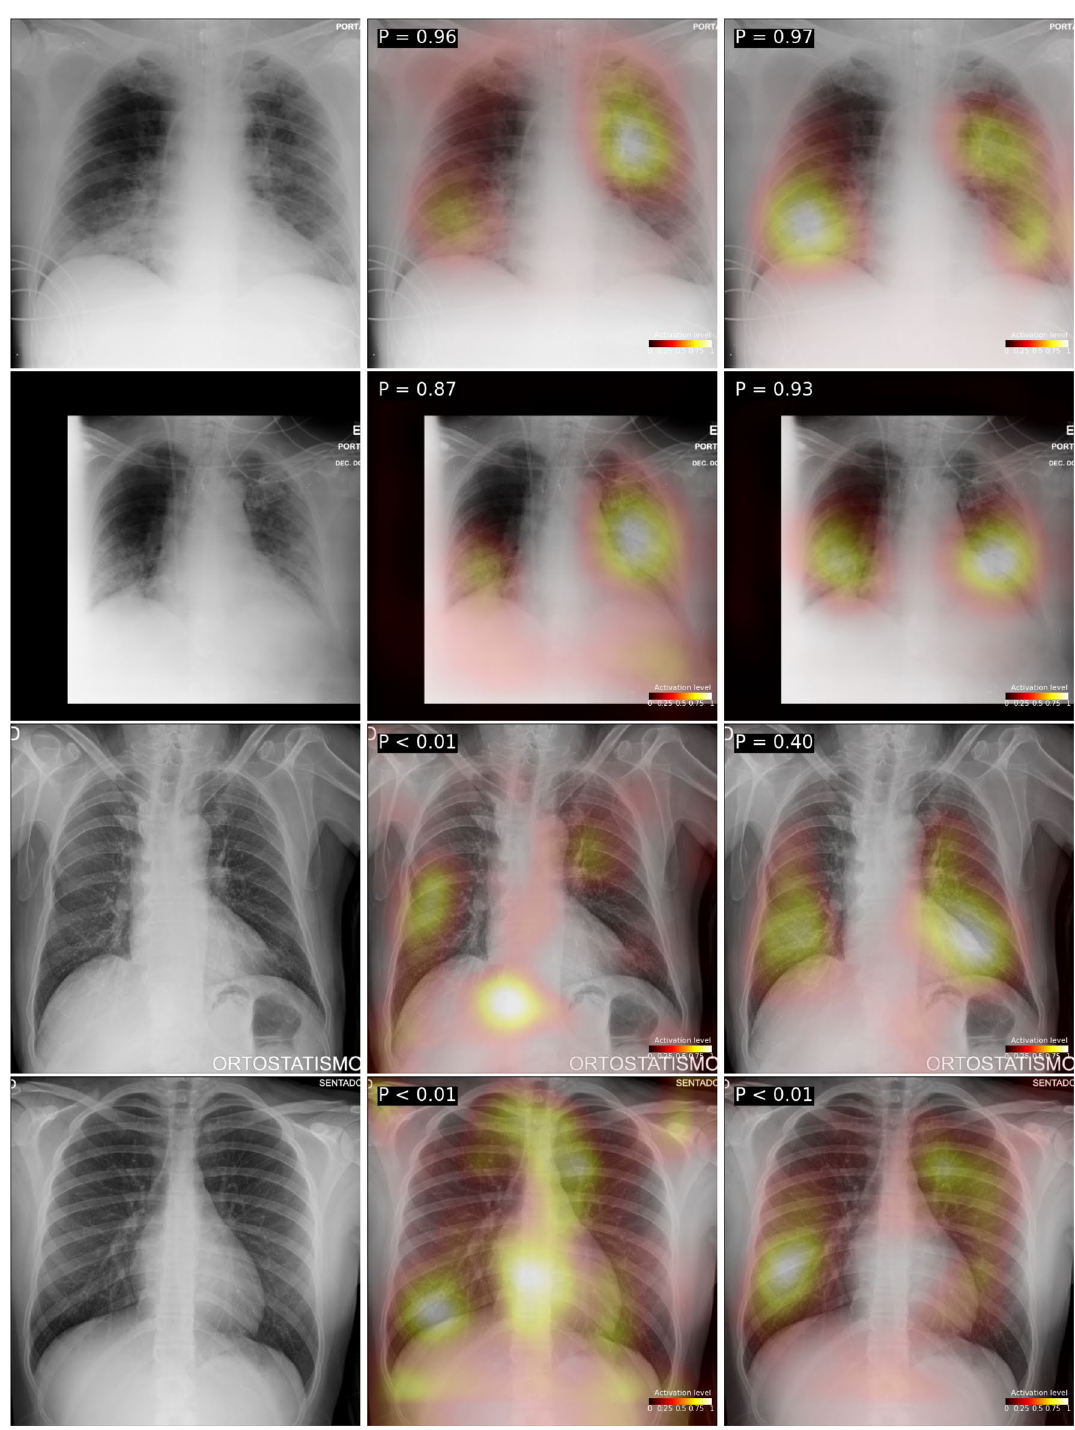
Figure 5. Examples of CXRs of COVID-19 positive patients from the CHVNGE dataset (first column) and corresponding GradCAM++ activation on the COVID-19 class for the M Mixed (second column) and the M MAnnot (third column). The first two rows correspond to CXRs correctly classified by M MAnnot with high probability, the third row corresponds to a CXR correctly classified by M MixedAnnot with average probability and the fourth row corresponds to a CXR incorrectly classified by M MixedAnnot with low